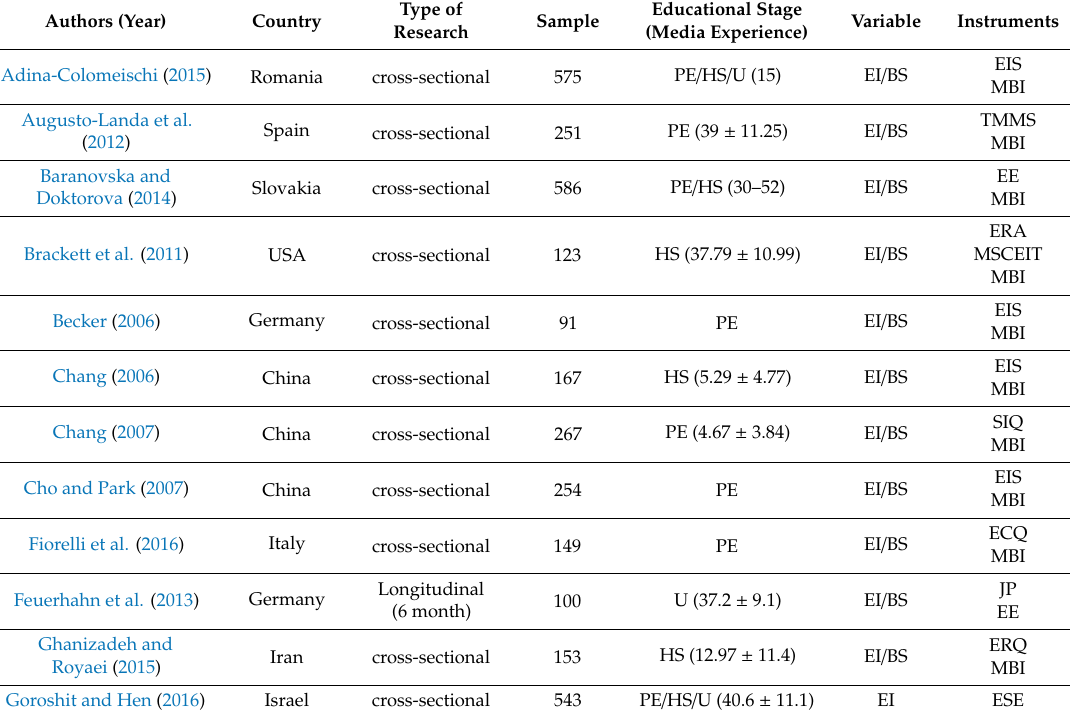
Table 1. Synthesis of the studies corresponding to the systematic review.